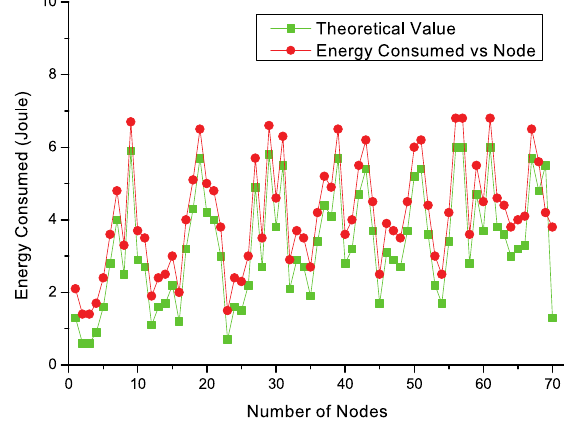
Figure 3. Energy consumed per node.